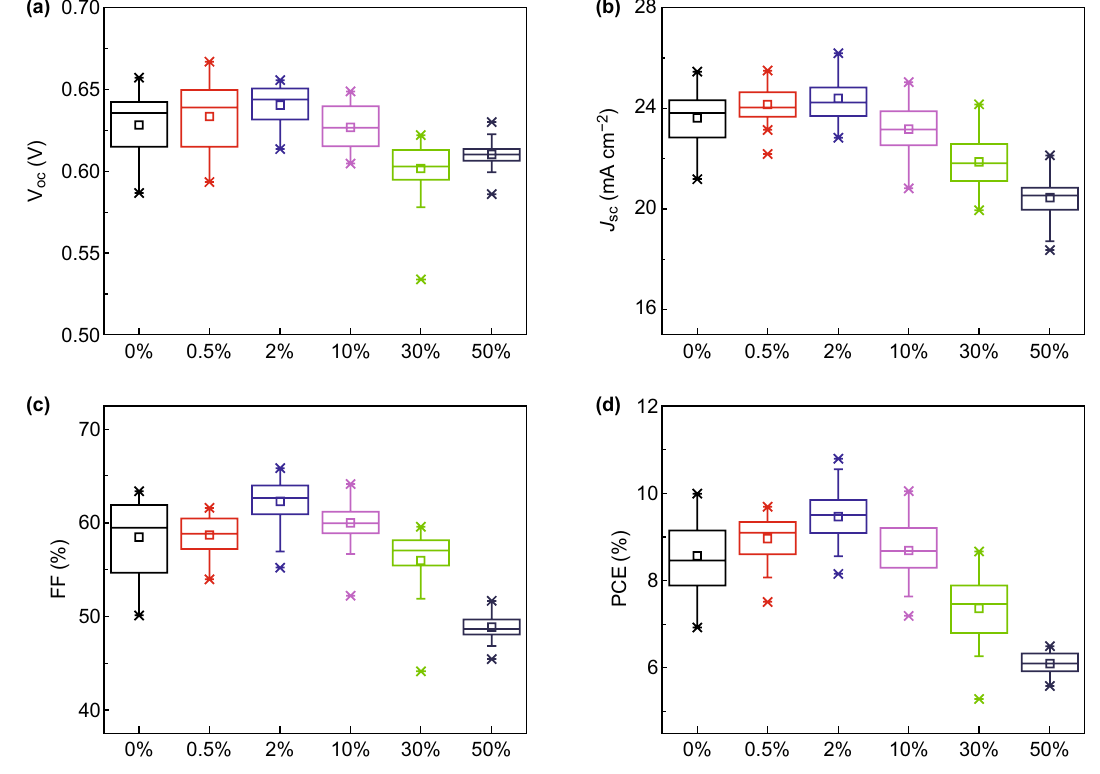
Fig. 4 Device performance parameters of a V oc , b J sc , c FF, and d PCE distribution box with different mole ratio of HI acid added in PbI 2 ‑PbS